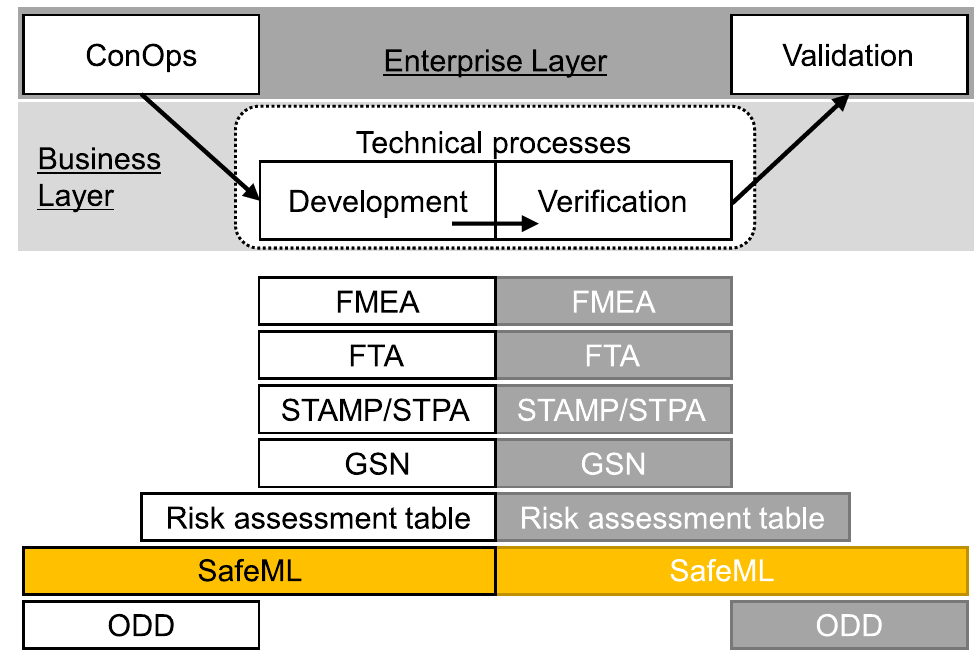
Fig. 6 Position of safety design method in the system